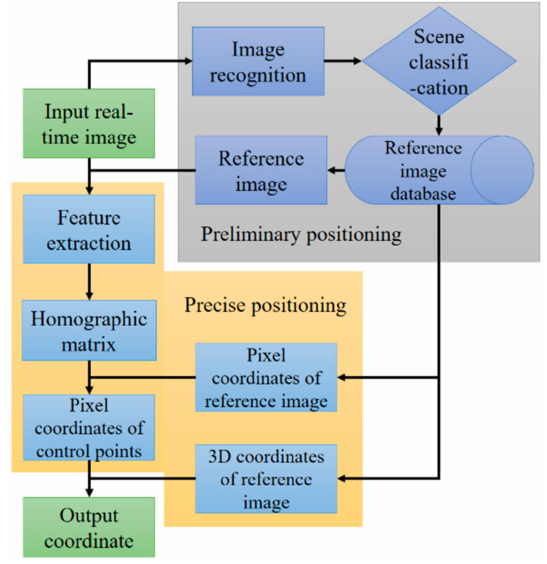
Figure 7. Flowchart of indoor positioning.